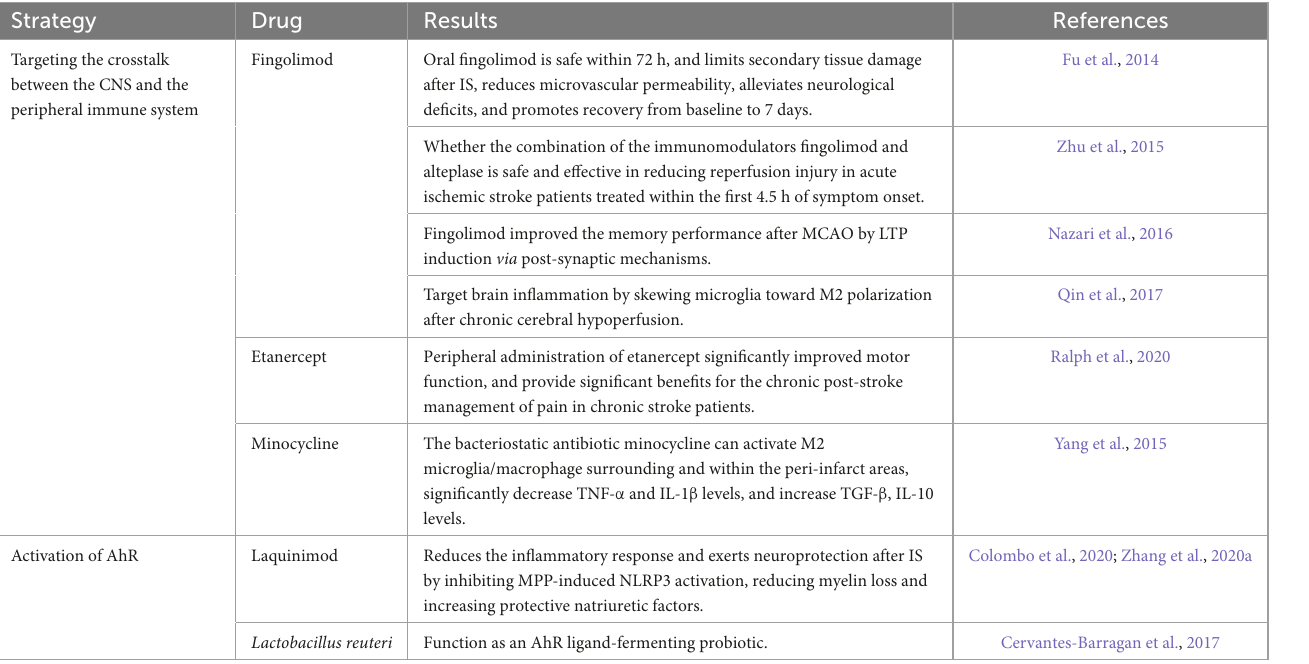
TABLE 1 Drugs that targeting gut-brain axis of ischemic stroke